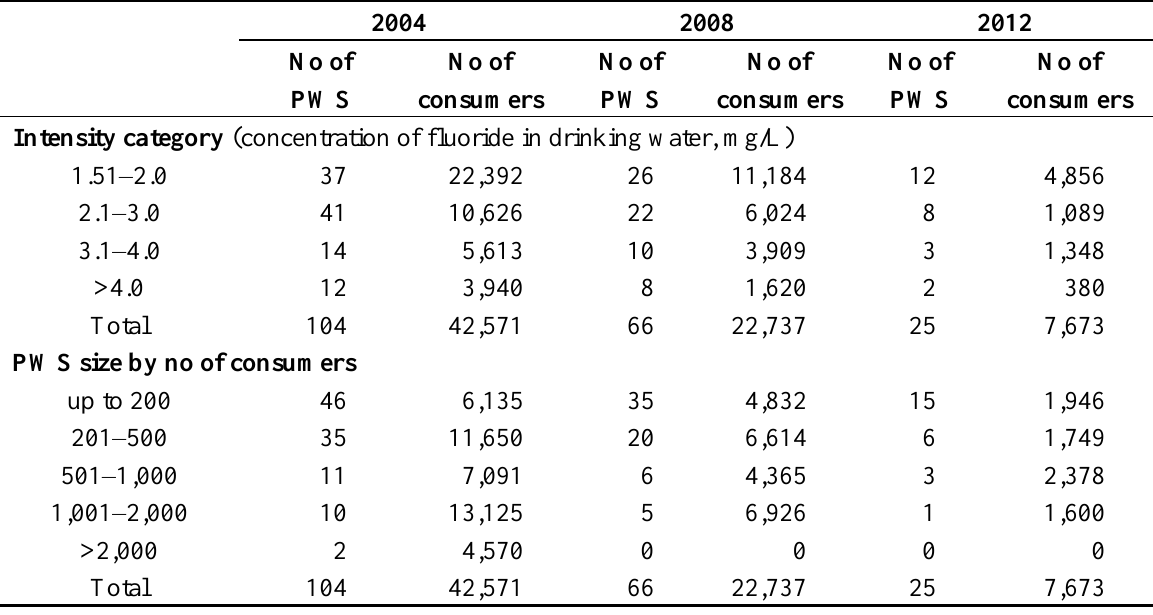
Table 1. Exposure to high fluoride drinking water by intensity category and size of public water supply (PWS) in 2004, 2008 and 2012.